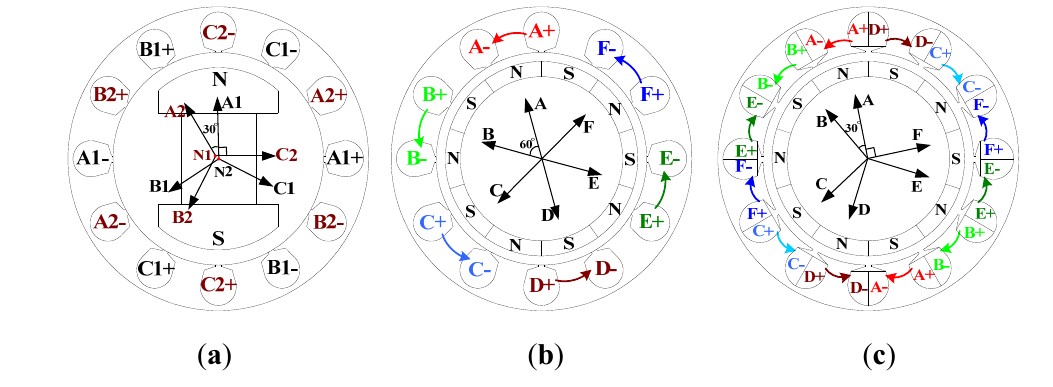
Figure 2. Configurations of six-phase PMSMs: ( a ) The dual three-phase PMSM; ( b ) The symmetric six-phase PMSM; ( c ) The semi-twelve-phase PMSM.